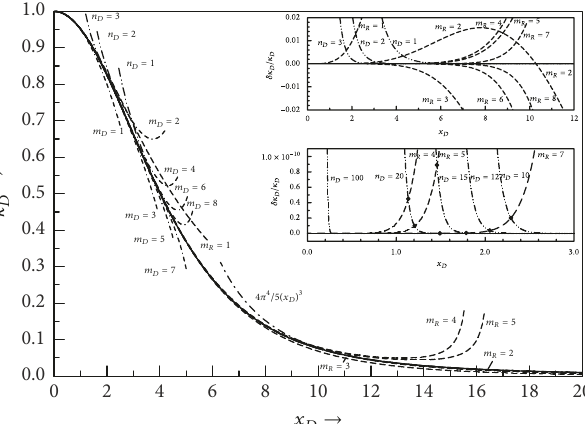
Figure 8: Visualization of the unusually rapid approaches of trun- cated versions of the presently developed (unprecedented) high- temperature 𝑥 2𝑚 𝐷 -series expansion, 𝜅 𝑚 𝑅 𝐷ℎ (𝑥 𝐷 ) (–– –––; see (A.11), for 𝑚 𝜅 (𝑥 ) function (—), in comparison with 𝑅 = 1 to 8), to the exact 𝐷 𝐷 the markedly slower approaches of truncated versions of Debye’s conventional high-temperature 𝑥 2𝑚 𝐷 -series expansion [1, 2, 16, 21, 54], 𝜅 𝑚 𝐷 𝐷ℎ (𝑥 𝐷 ) (–– ⋅ – – ⋅ –; see (A.7), for 𝑚 𝐷 = 1 to